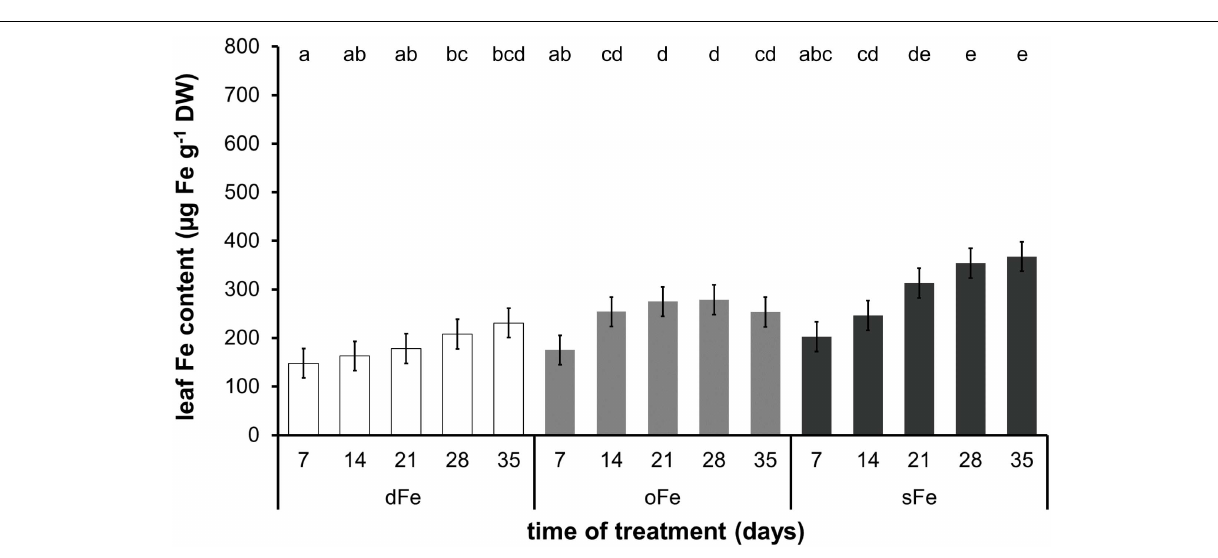
FIGURE 3 | Fe content of the 6th leaves of plants grown on deficient (dFe), optimal (oFe), and supraoptimal (sFe) Fe supply, represented by open, light grey and dark grey columns, respectively, on a dry weight (DW) basis of leaves. Error bars represent SD values. To compare the differences, one-way ANOVA was performed with Tukey–Kramer post hoc test on the treatments [ P < 0.05; n = 3 × 3 (biological ×